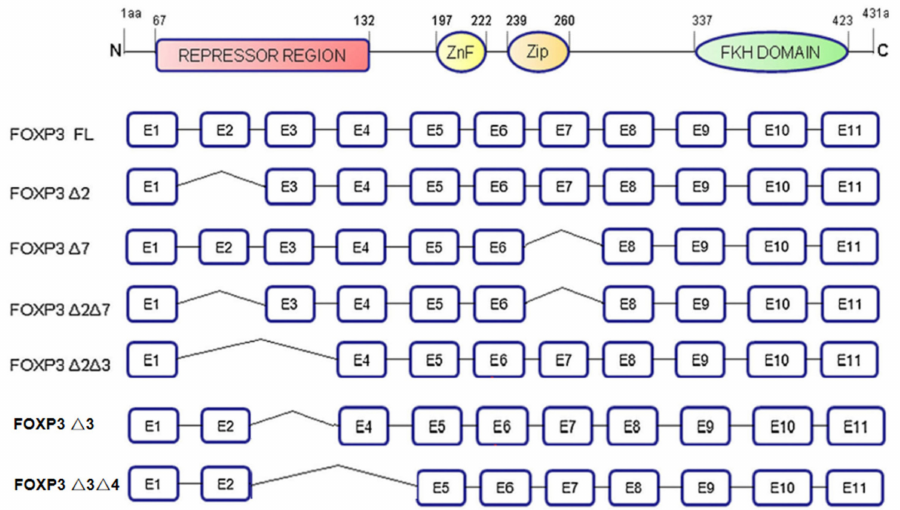
Figure 2. The structure of FOXP3 and its isoforms. FOXP3 gene contains 4 domains, including N-terminal domain, zinc-finger motif, leucine-zipper motif, and FKH domain. FOXP3 is classified into seven different isoforms based on different exons deletion.